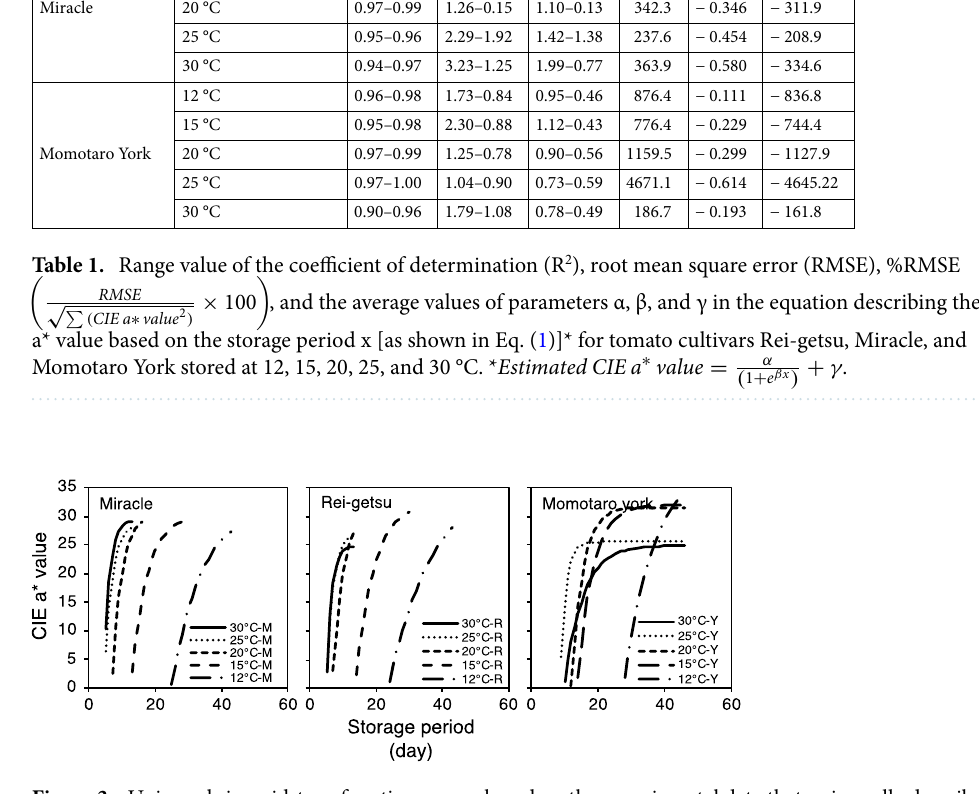
Figure 3. Universal sigmoid-type function curves based on the experimental data that universally describe the red color development of cultivars Miracle (M), Rei-getsu (R), and Momotaro York (Y) stored at 12, 15, 20, 25, and 30